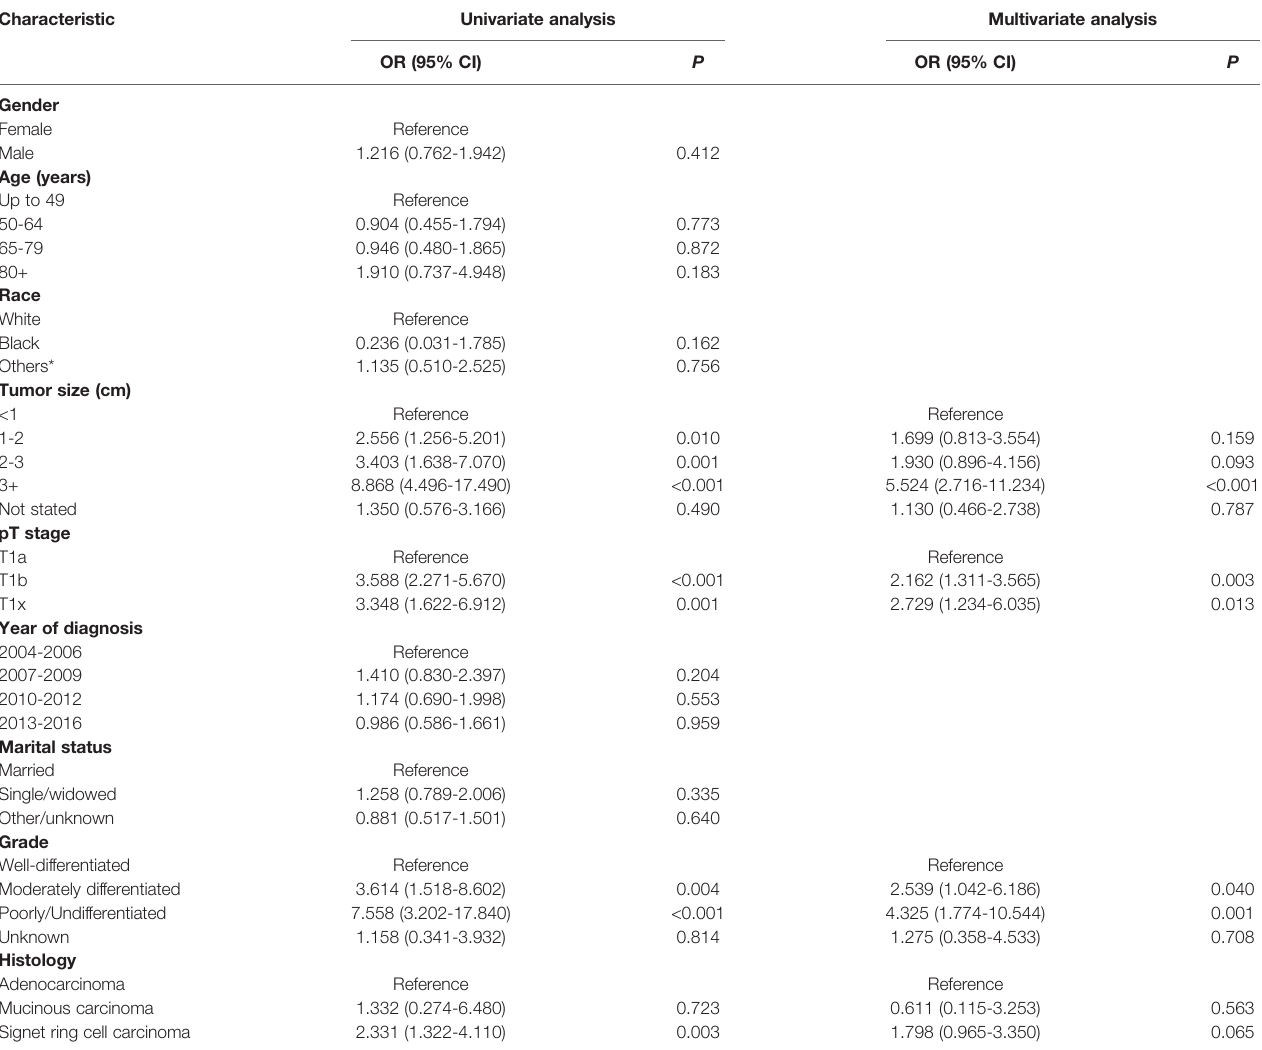
TABLE 2 | Logistic regression analysis of the risk factors for lymph node metastasis in early-stage esophagogastric junction cancer (LNE ≥ 16).